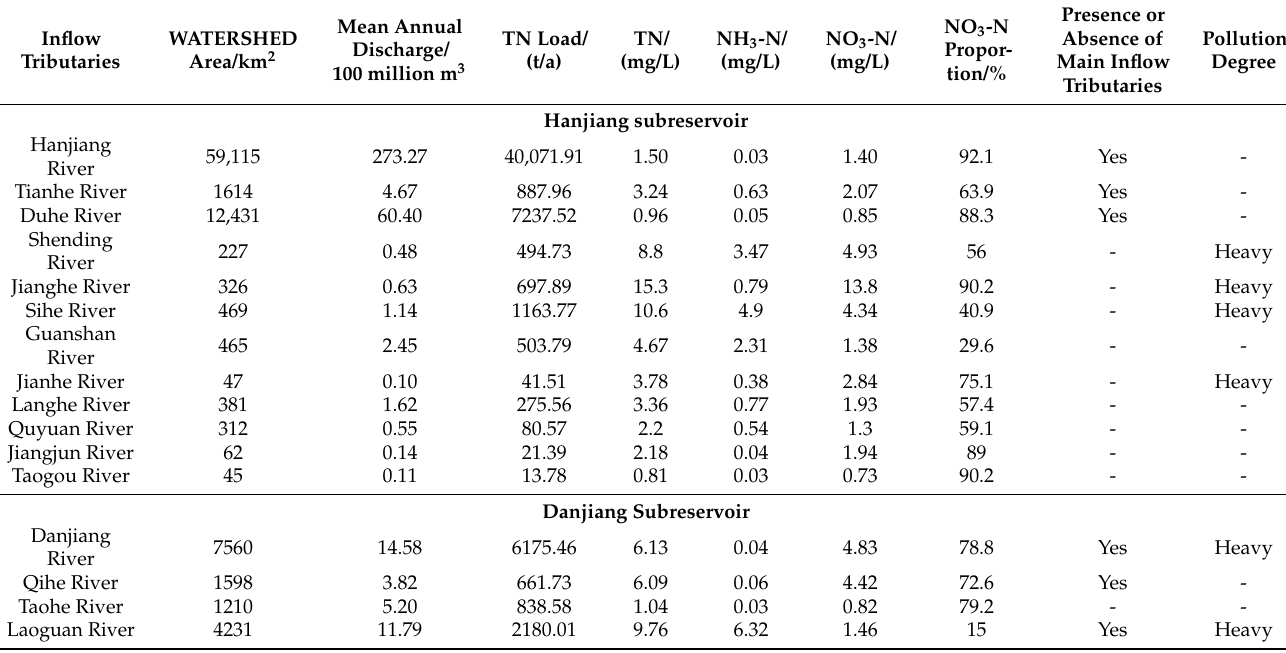
Table 2. Characteristics of the main inflow tributaries of the Danjiangkou Reservoir (2016).